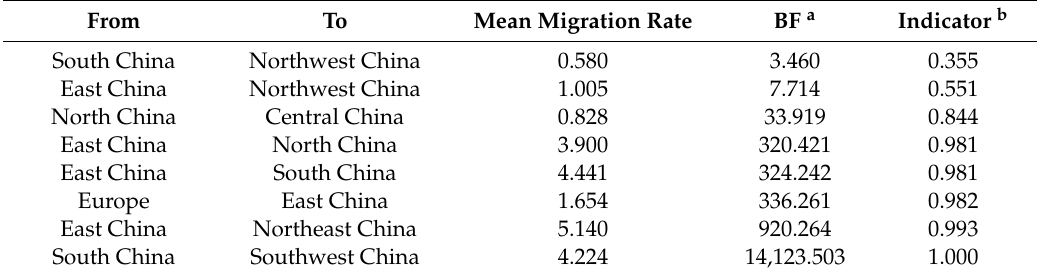
Table 2. Statistically supported migration rates of VI.2.1.1.2.2 PPMV-1 estimated from the F gene. From To Mean Migration Rate BF a Indicator b South China Northwest China 0.580 3.460 0.355 1.005